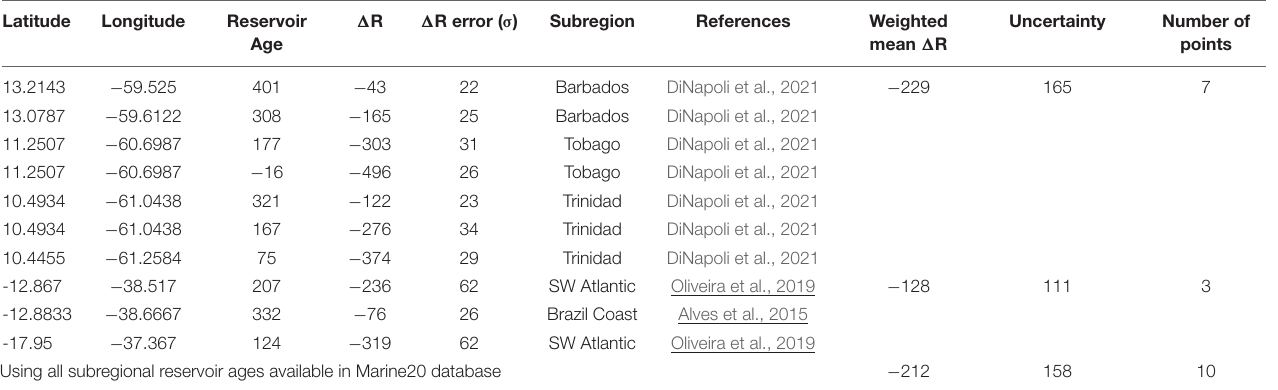
TABLE 1 | Regional reservoir ages and corrections from the Caribbean and western tropical Atlantic extracted from the Marine20 database (Stuiver et al., 2021).